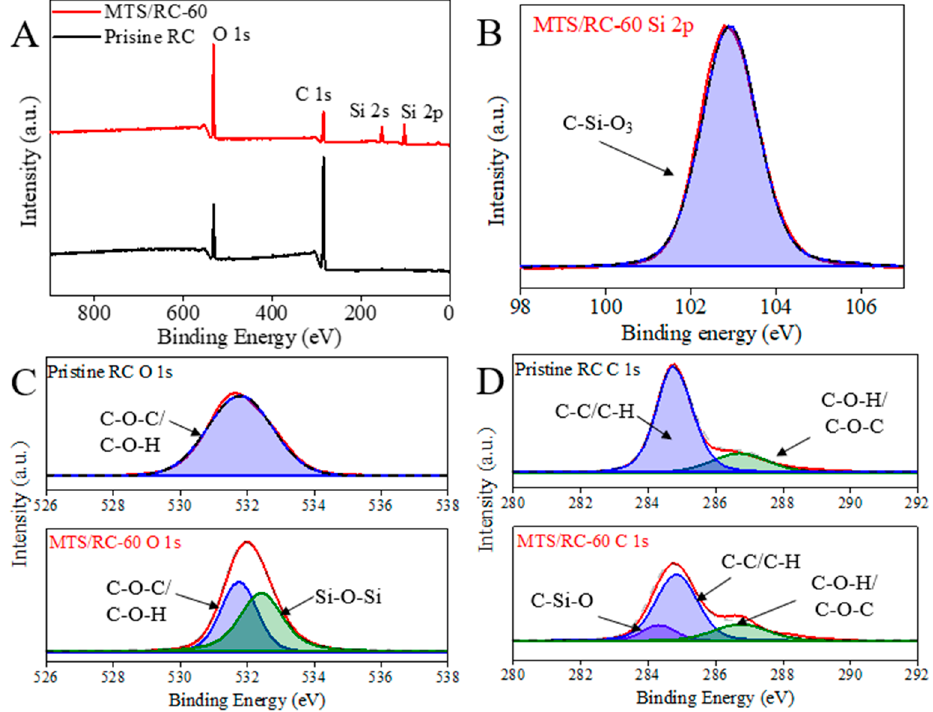
Figure 4. ( A ) XPS spectra of pristine RC and MTS/RC-60 film. ( B ) High-resolution spectrum Si 2p of MTS/RC-60 film. ( C , D ) High-resolution spectra O 1s and C 1s of pristine RC and MTS/RC-60 films.